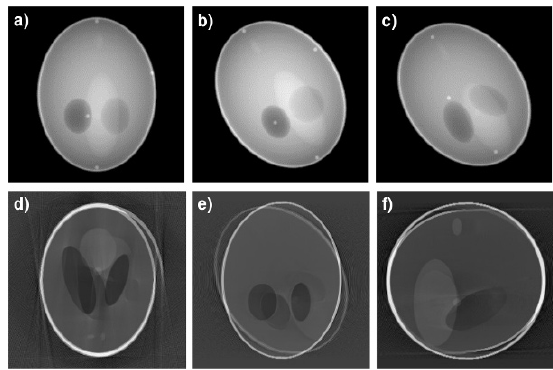
Figure 6. (a–c) projection at 260°, 270° and 280° source position; (d– f) axial, coronal and sagittal slices of the rotational motion corrupted reconstructed volume.